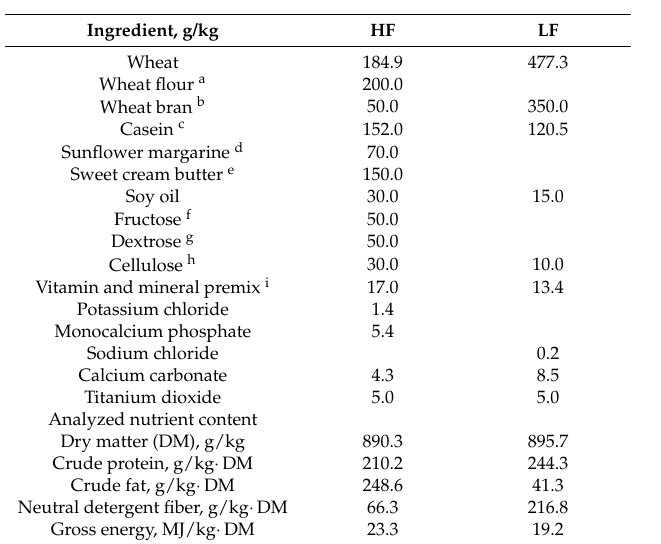
Table 1. Ingredient composition, nutrient and energy content of the high-fat/low-fiber (HF) and low-fat/high-fiber (LF)